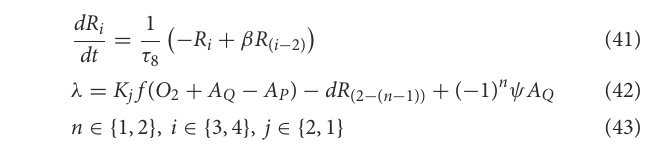
For the generation of the right-turn swing oscillations (Figure 8B), the same structure and principle is used. However, care must be taken, once again, with the connections of the adaptation units. In this case, the right-turn adaptation ( A Q